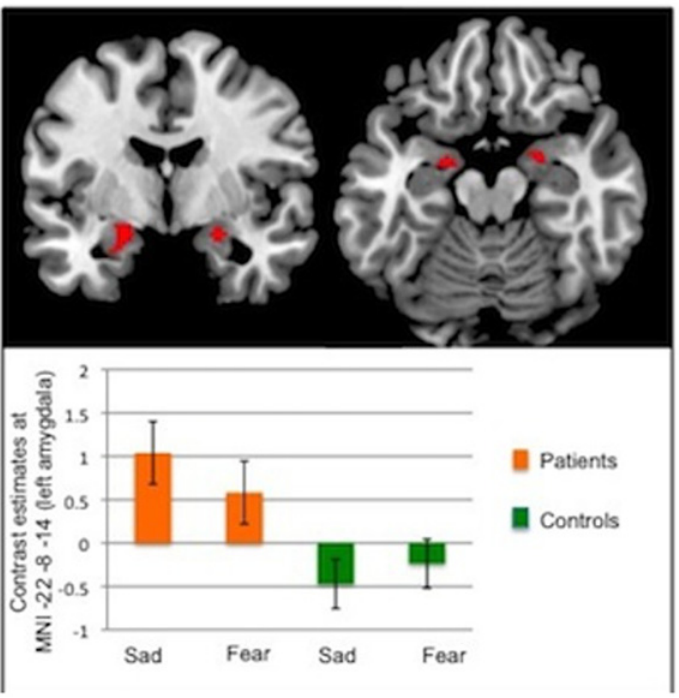
Fig 1. ROI analysis: Group effect in the Emotion Model. Upper panel : Activation in the amygdalae in response to emotional faces showing a group effect (CD patents > healthy controls). Statistical maps have been thresholded at p < 0.005 uncorrected for display purposes. A significant increased activity was found in the left amygdala (FWEp = 0.027, z = 3.3, [ – 22 – 8 – 14]). Of note, the right amygdala activation displayed here did not reach conventional levels of significance after correction for multiple comparisons (FWE p = 0.078 at MNI [22 – 4 – 14]). Lower panel : Graph showing contrast estimates for left amygdala activation in response to each negative emotion (sad, fear) separately for the 2 groups: CD patients (in orange) and healthy controls (in green).